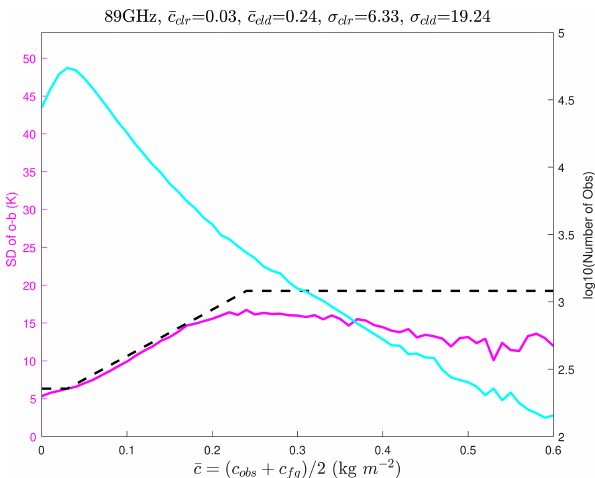
Figure 1. All-sky observation error model for NOAA-19 AMSU- A channel 15. The magenta curve is the statistics of the standard deviation of O minus B (left y axis) as a function of the model– observation-averaged cloud liquid water path ( x axis). The cyan curve gives the number of observations (right y axis) used in each bin’s statistics (0.01kgm − 2 bin interval). The dashed black curve is the fitted piecewise-linear ramp function of the magenta curve, serving as the all-sky observation error model. Variables in the title are those of Eq. (11) in Sect.